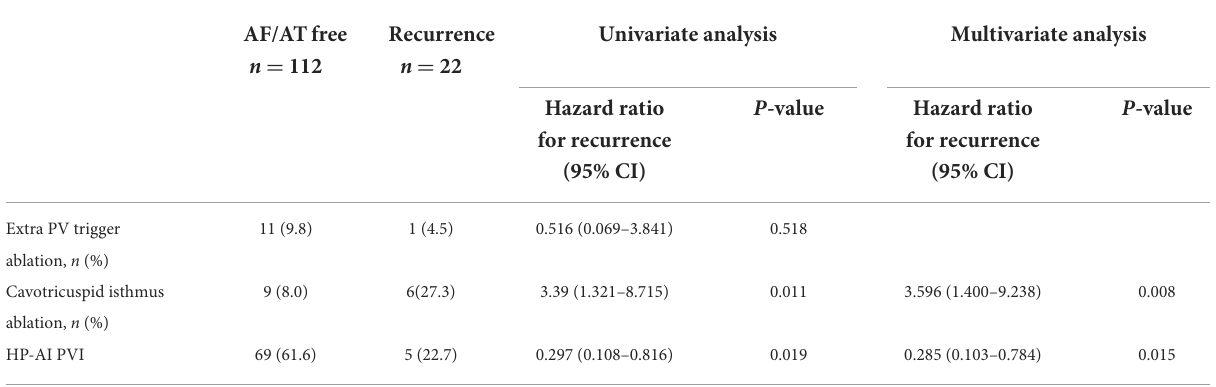
TABLE 4 Ablation characteristics for